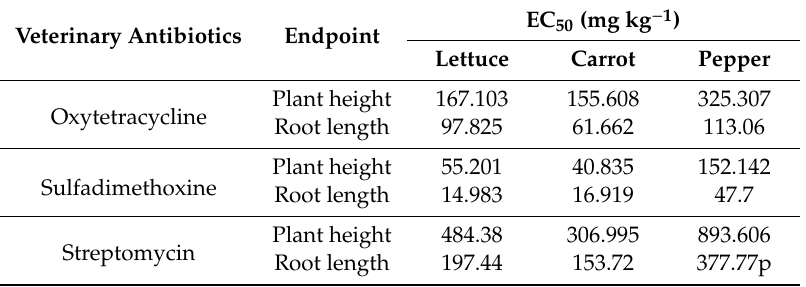
Table 3. Toxicity data from plant growth tests in soil for lettuce, carrot, and pepper